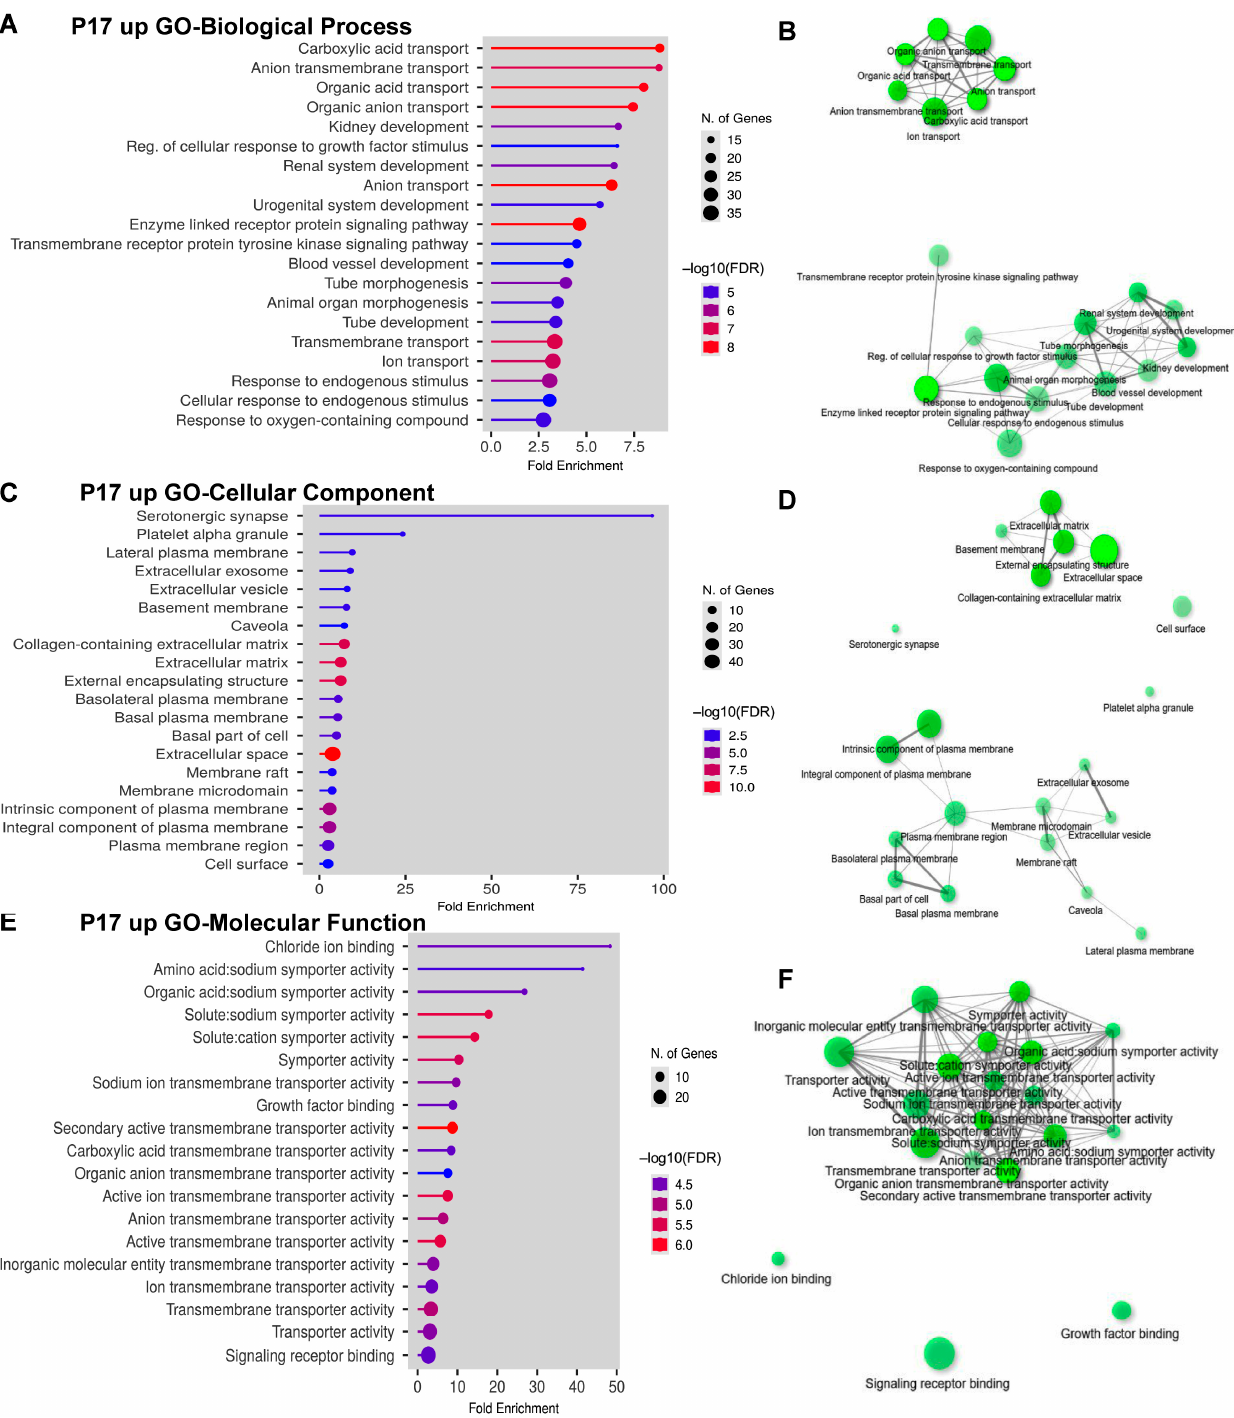
Figure 5. GO analysis of DEGs that are upregulated at P17. ( A ) Bar dot plot of GO analysis of biological process on upregulated DEGs from brains at P17. ( B ) Network plot of GO analysis of biological process on upregulated DEGs from brains at P17. ( C ) Bar dot plot of GO analysis of cellular component on upregulated DEGs from brains at P17. ( D ) Network plot of GO analysis of cellular component on upregulated DEGs from brains at P17. ( E ) Bar dot plot of GO analysis of molecular function on upregulated DEGs from brains at P17. ( F ) Network plot of GO analysis of molecular function on upregulated DEGs from brains at P17.